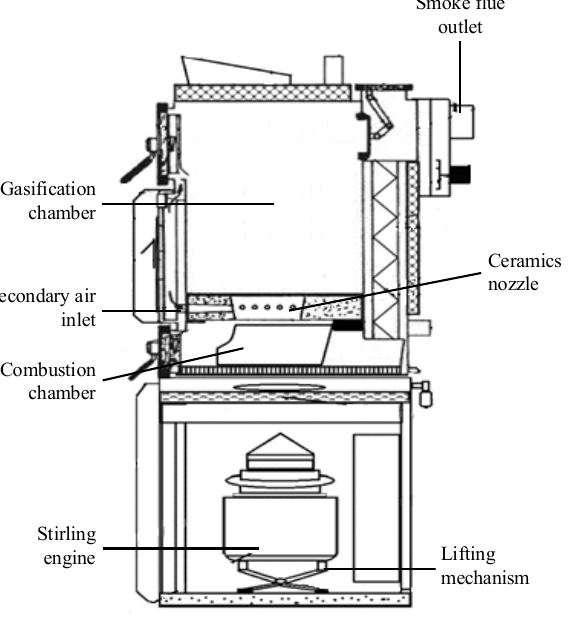
Fig. 2 . Schematic representation of the experimental equipment with the lifting mechanism